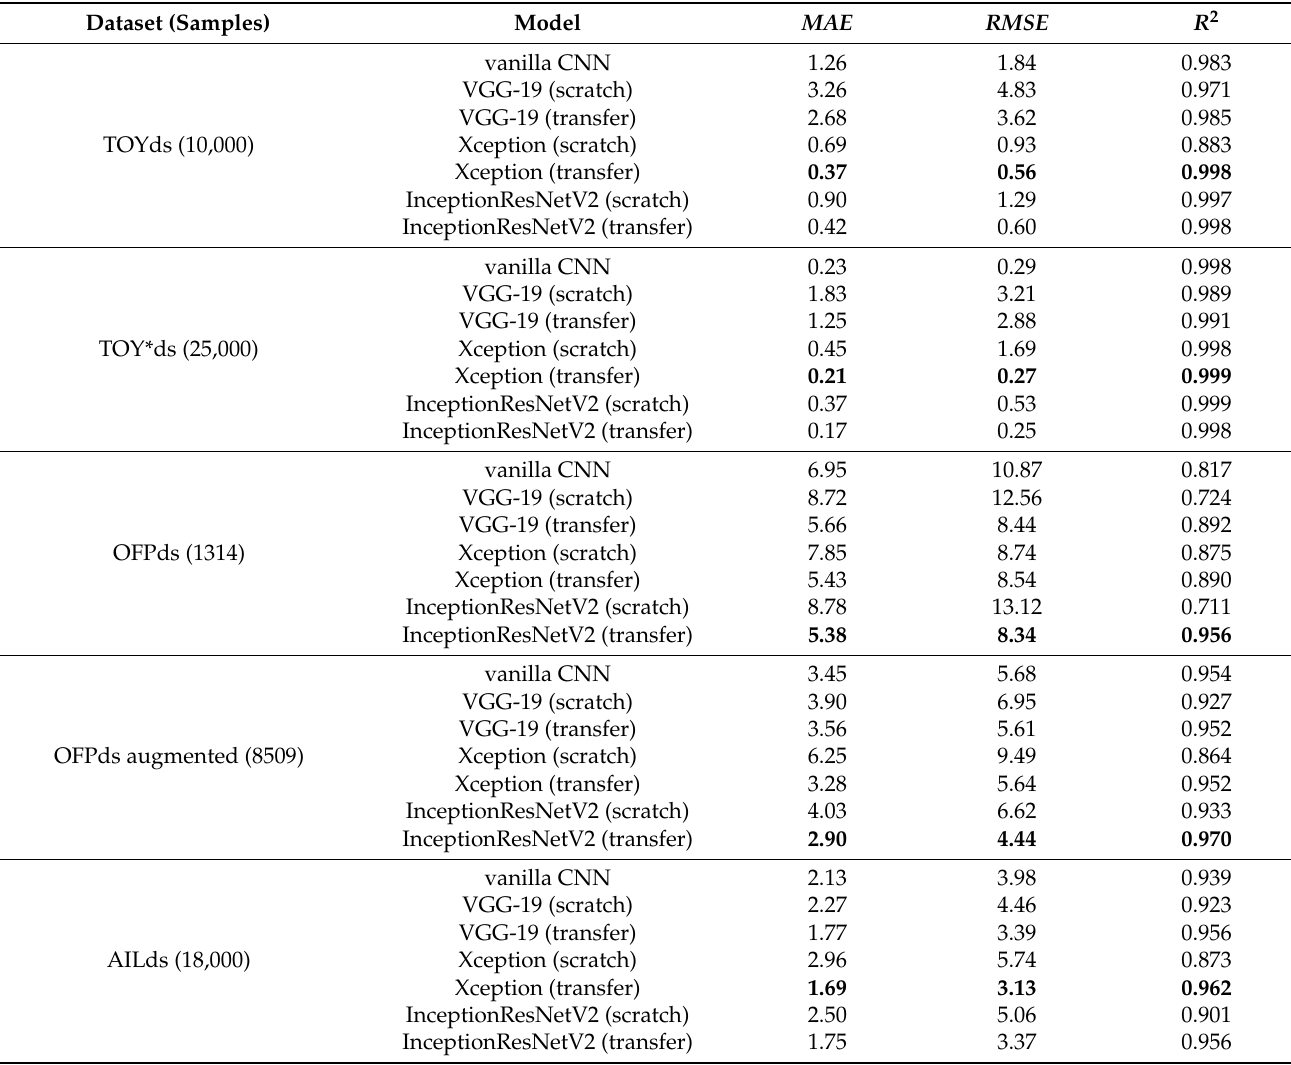
Table 1. The prediction performance of the CNN-based models on the test